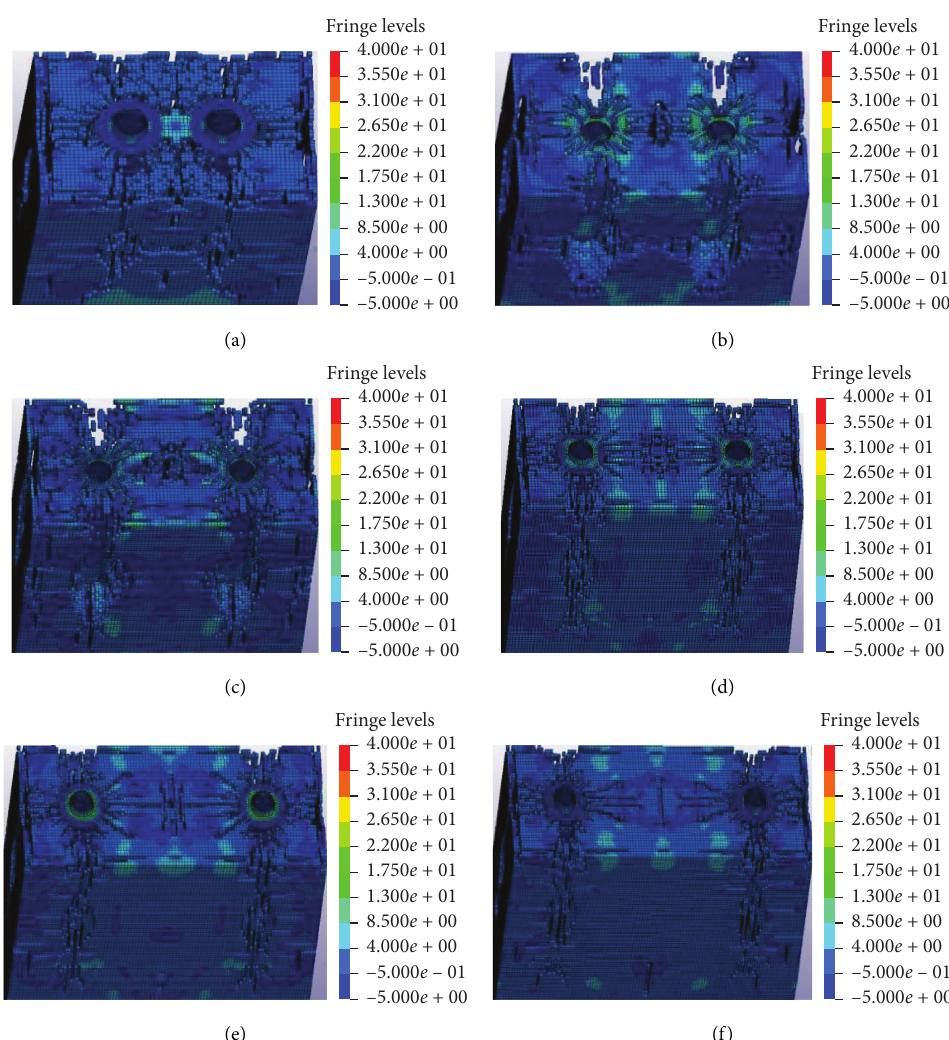
Figure 12: Simulation results of beams with different hole spacing when the aperture is 70 mm. (a) S � 200 mm. (b) S � 300 mm. (c) S � 400 mm. (d) S � 500 mm. (e) S � 600 mm. (f) S � 700